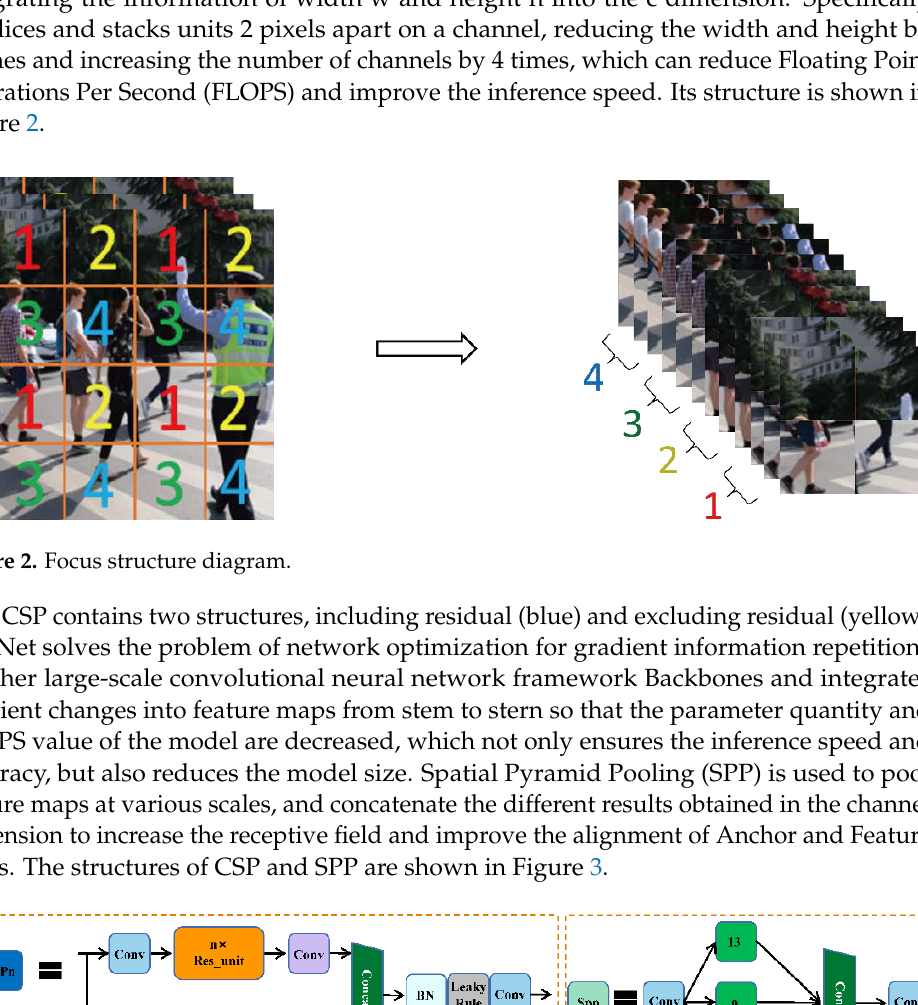
Figure 1. YOLOv5 algorithm structure diagram.